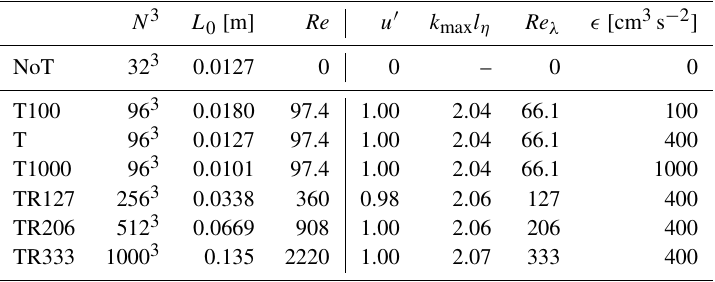
Table 4. Case configurations and typical turbulence statistics. Re = U 0 L 0 /ν , where U 0 is the representative velocity and L 0 is the represen- tative length, u (cid:48) is the rms of the flow velocity fluctuation, k max ( = N/ 2 ) is the maximum wavenumber, l η is the Kolmogorov scale, λ is the local shear rate, and Re λ is the Taylor-microscale-based Reynolds number. N 3 L 0